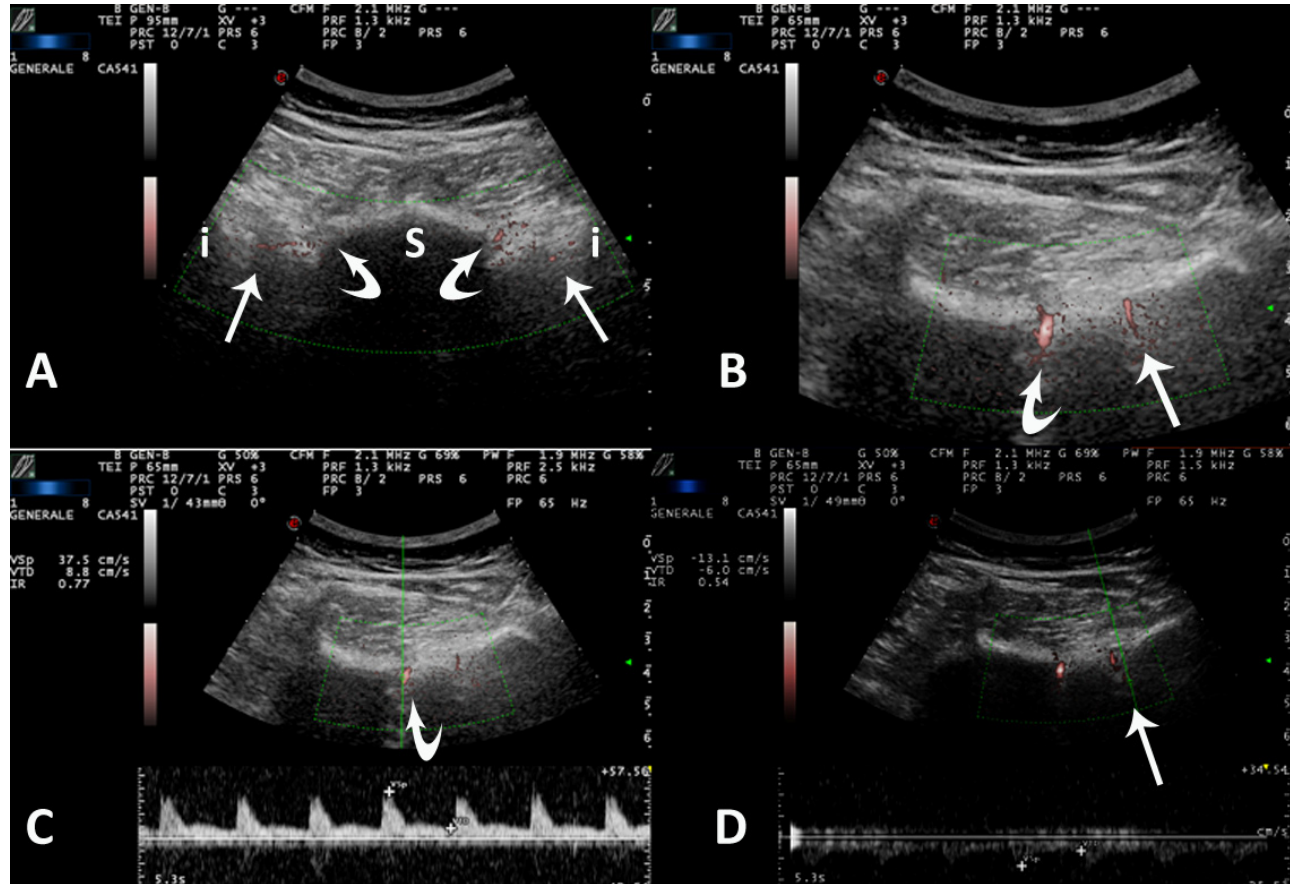
Figure 1. Axial posterior scan over SIJs in a 15 − year − old girl with jSpA. ( A ) Panoramic view that includes both SIJs (straight arrows). The profile of sacrum (s) is interrupted by the first sacral foramen (curved arrow) on both sides. i = ilium. Vascular signals can be observed into both sacral foramen and SIJs. ( B ) In a more distal axial scan over right side, clear vascular flows can be observed in the sacral foramen (curved arrow) and in the cleft of right SIJ (straight arrow). ( C ) The application of pulsed wave (PW) Doppler with spectral wave analysis (SWA) on the signal of sacral foramen (curved arrow) shows a high resistance normal flow (RI 0.77). ( D ) The application of pulsed wave (PW) Doppler with spectral wave analysis (SWA) on the signal of sacroiliac cleft (straight arrow) shows a low resistance flow (RI 0.54) suggesting vasodilatation due to SIJ